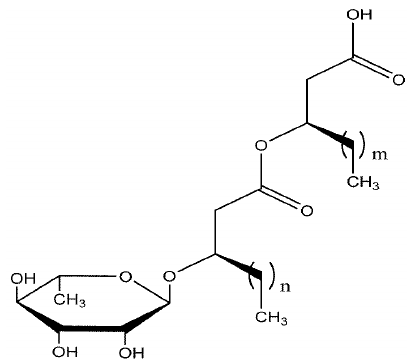
Figure 1. Structure of monorhamnolipids utilized in this study. The varying chain lengths of the monorhamnolipid congeners are represented by ‘m’ and ‘n’ which vary from 4 to 12.